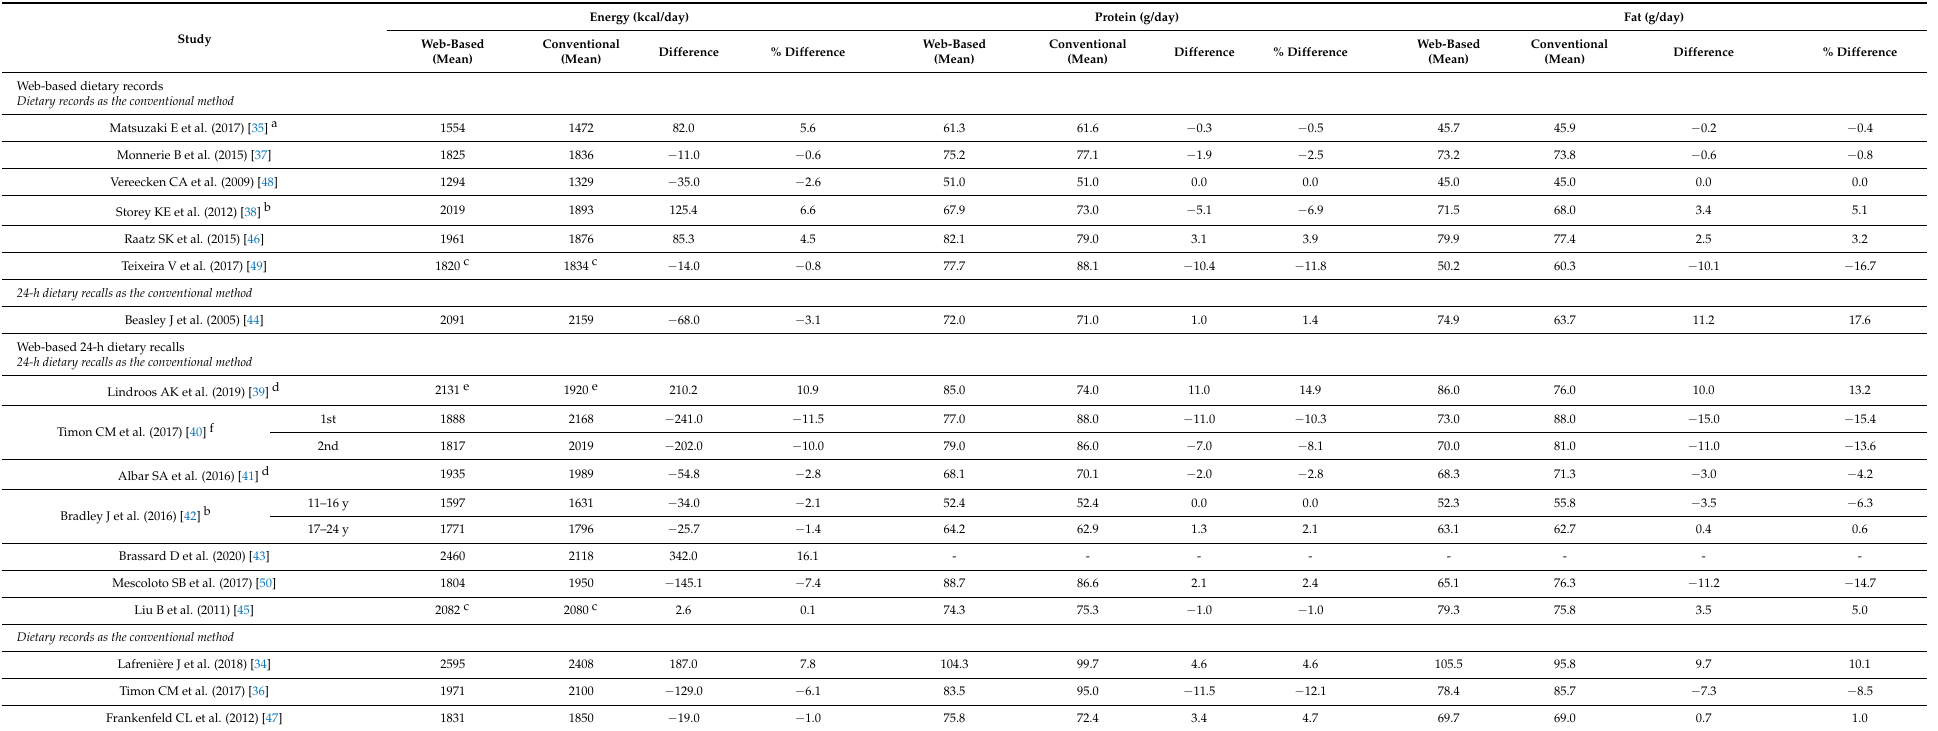
Table 2. Intakes of energy, macronutrient, sodium, vegetables and fruits using the web-based and conventional dietary assessment